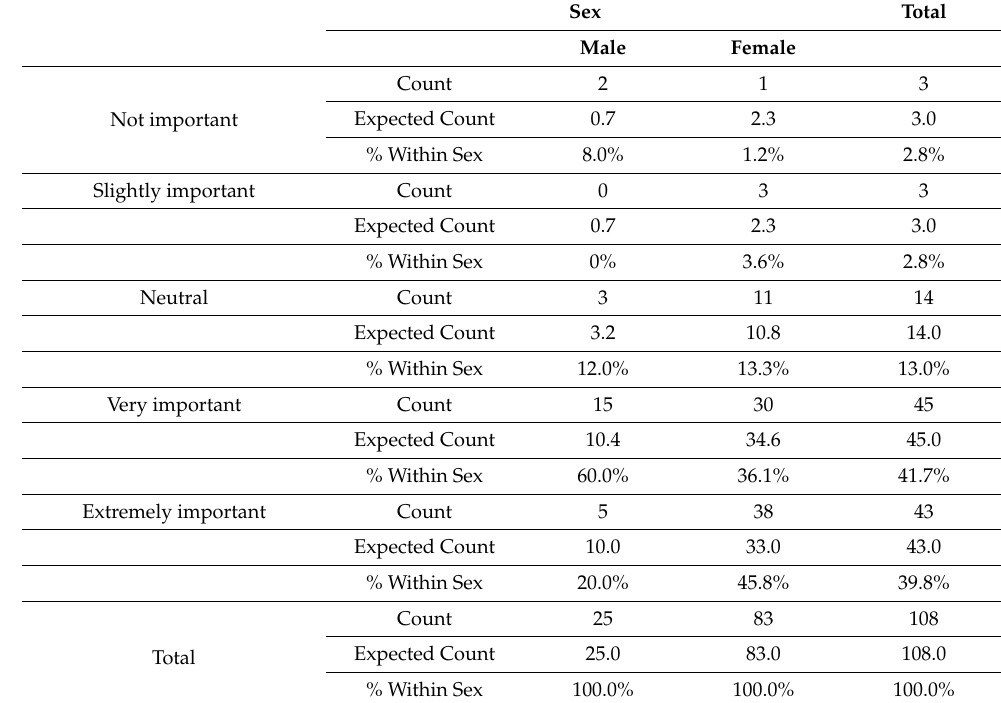
Table 10. Importance of Trust While Working with the JSU JHS CORC by